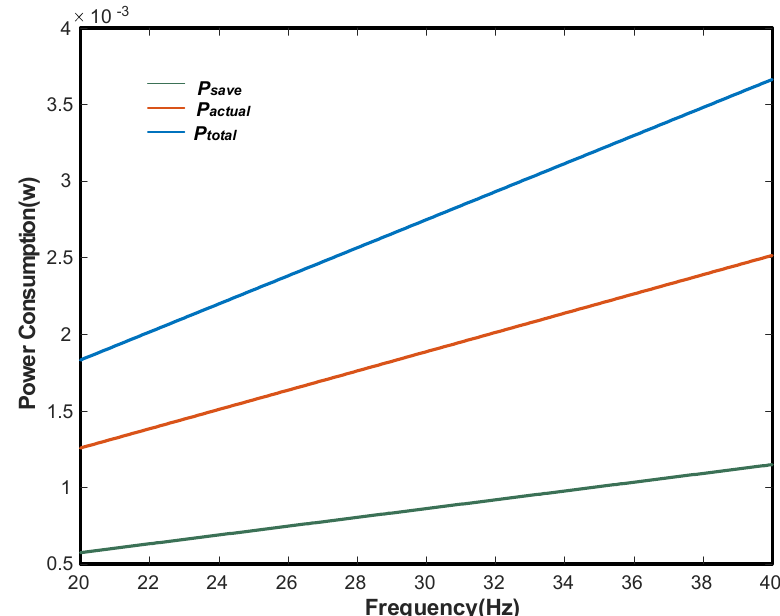
Figure 15. Power consumption at different frequencies.